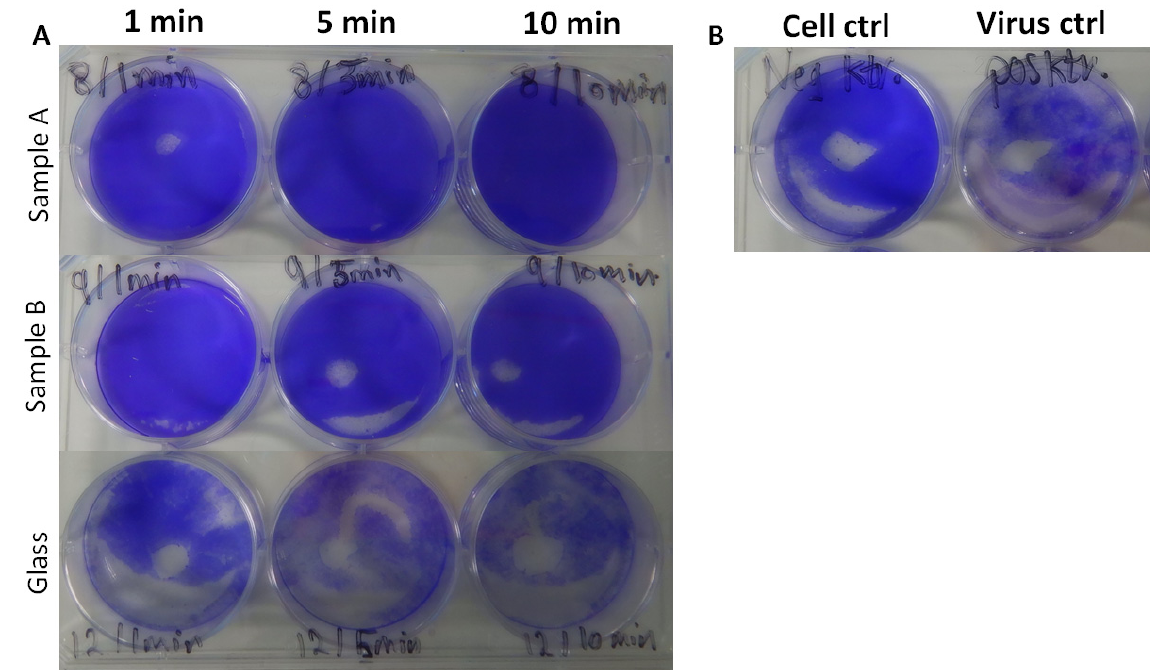
Figure 6. ( A ) Image demonstrating the inhibition of the Alpha variant growth on Cu–Ag nanocomposite-plated surfaces (samples A and B) after 1, 5, and 10 min, based on crystal violet-stained Vero E6 cells. ( B ) Image of cells without the virus used as a negative control and viral cultures without the surface treatment used as a positive control. The blank color shows cell death caused by, for example, viral growth, cells’ aging, or mechanical stressors), and the deep violet color demonstrates an intact cell layer.